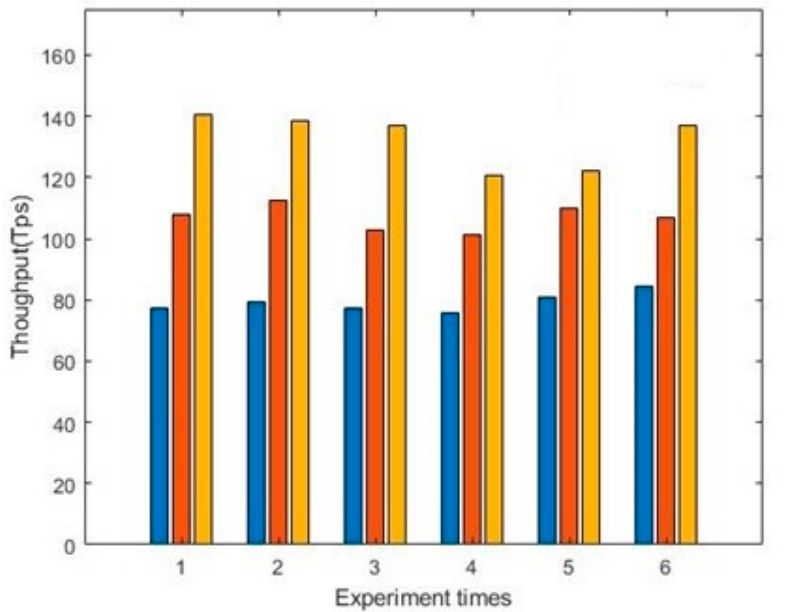
Figure 9. Throughput comparison between master and slave chains.